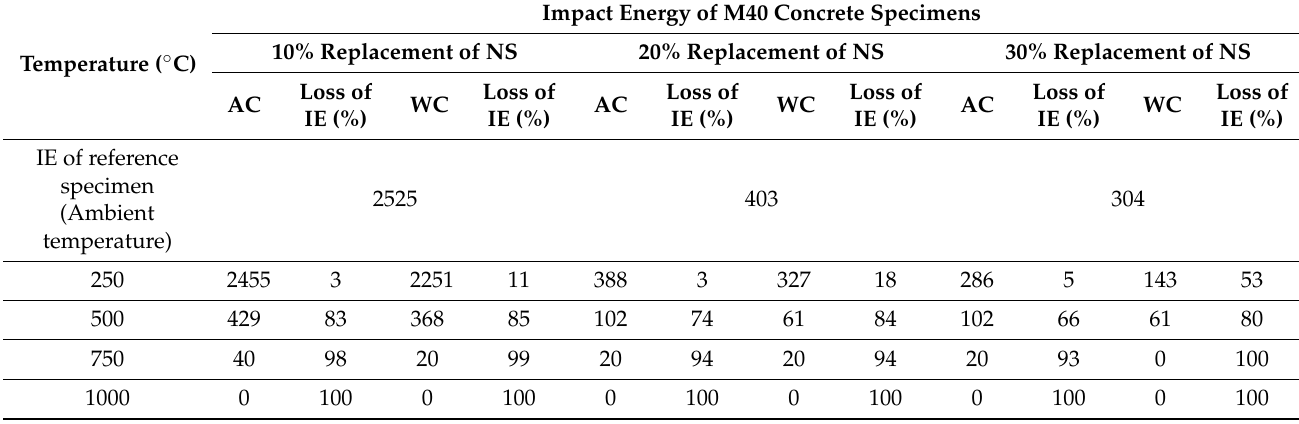
Table 6. The impact energy of specimens cast with NS.